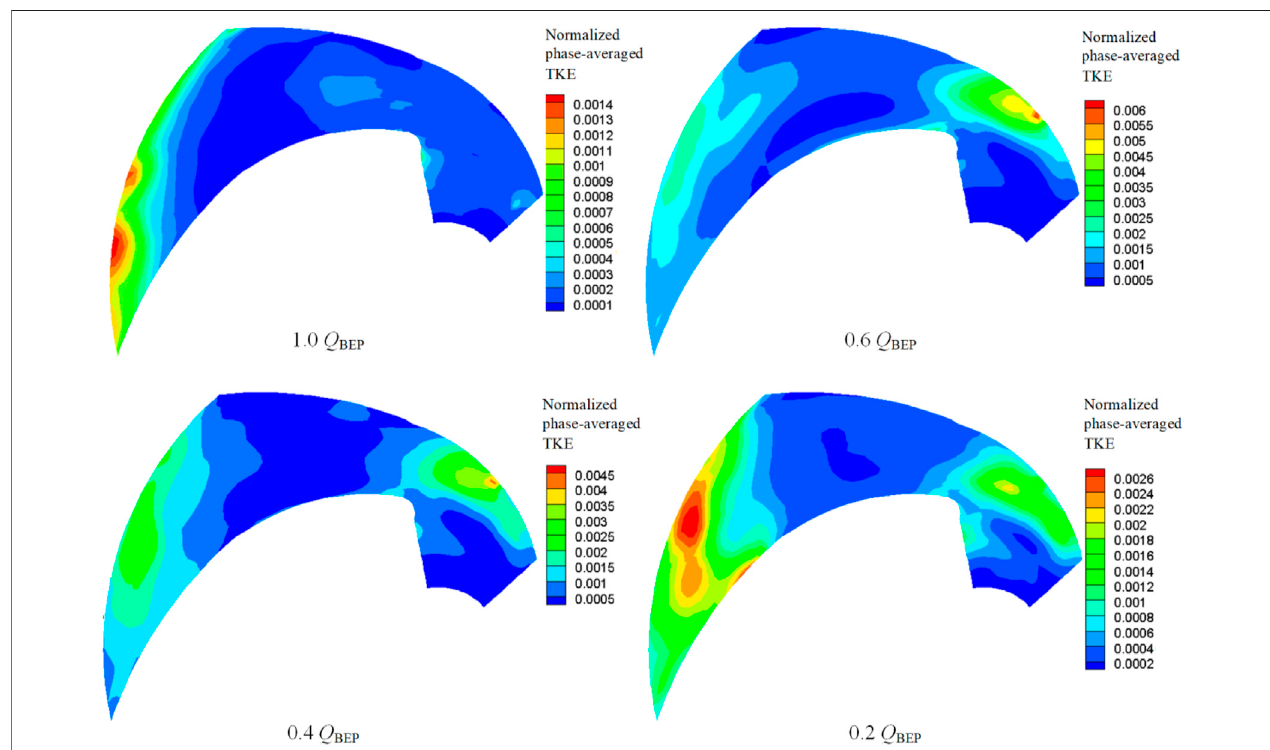
FIGURE 3 | Normalized phase-averaged TKE